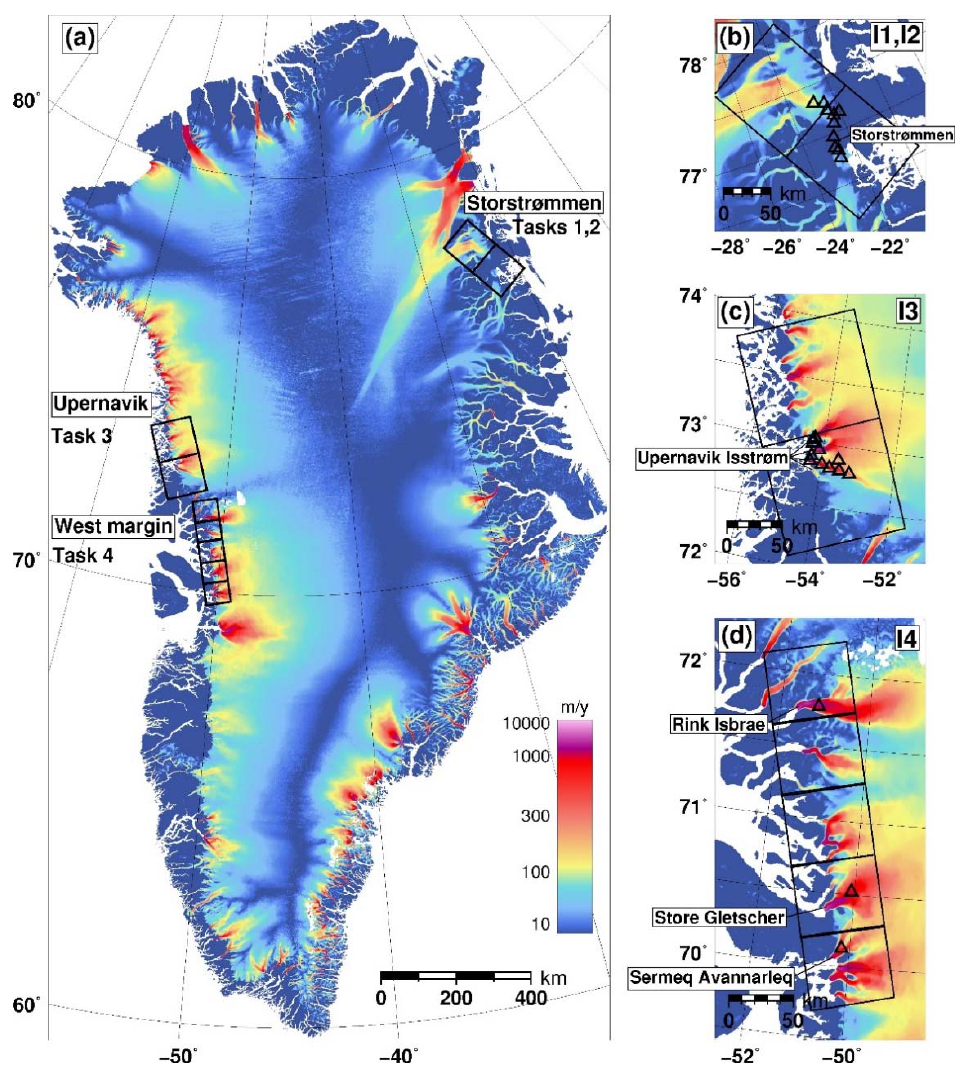
Figure 1. ( a ) SAR data frames (rectangles) and GPS stations/stakes used for validation (triangles) plotted on a horizontal velocity magnitude mosaic generated from Sentinel-1a/b SAR data acquired between October 2015 and October 2016 (©ENVEO). Insets represent the Storstrømmen ( b ); Upernavik ( c ) and central west ice margin ( d ) test sites referred to in Table 1.